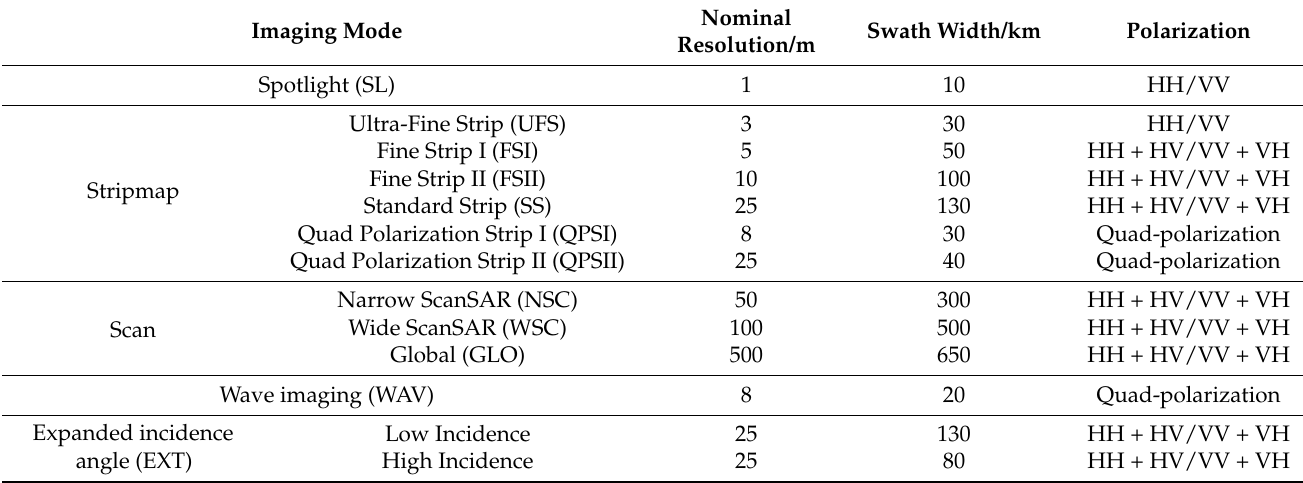
Table 1. Imaging modes and parameters of C-SAR/01.